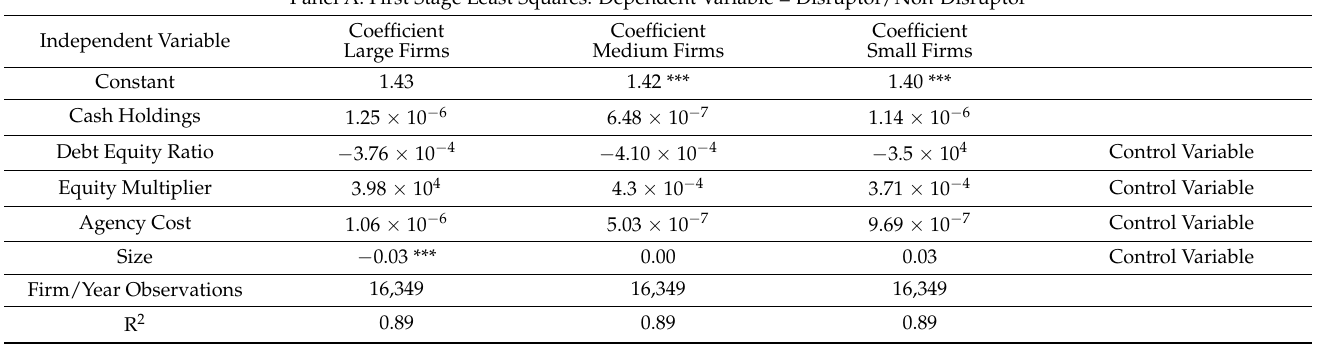
Table 6. Effect of Varying Asset Sizes. Two-Stage Least Squares Regressions of Cash Holdings on Disruption, Followed by Disruption on Financial Performance. Panel A: First Stage Least Squares: Dependent Variable =